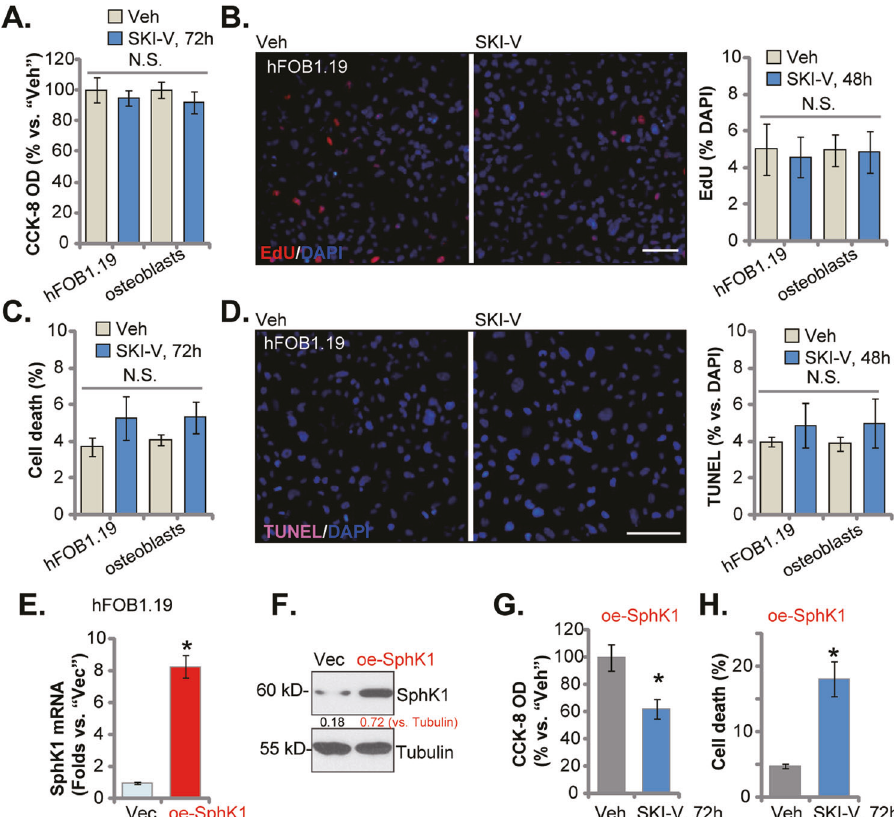
Fig. 3 The effect of SKI-V in hFOB1.19 human osteoblastic cells and primary osteoblasts. The hFOB1.19 human osteoblastic cells or the primary human osteoblasts ( “ osteoblasts ” ) were cultured and treated with SKI-V (25 μ M) for applied time periods; cell viability, proliferation, death, and apoptosis were tested by CCK-8 ( A ), nuclear EdU staining ( B ), trypan blue staining ( C ) and nuclear TUNEL staining ( D ) assays, respectively. “ Veh ” stands for the vehicle control. Data were presented as mean ± standard deviation (SD, n = 5). Expression of the SphK1 mRNA ( E ) and protein ( F ) in the stable hFOB1.19 cells with the SphK1-expressing lentiviral construct ( “ oe-SphK1 ” ) or the empty vector ( “ Vec ” ) was shown. The oe-SphK1 hFOB1.19 cells were treated with SKI-V (25 μ M) or vehicle control for 72 h; cell viability and death were tested by CCK-8 ( G ) and trypan blue staining ( H ) assays, respectively. “ N. S. ” stands for non-statistical difference ( P > 0.05). * P < 0.05 vs . “ Vec ” / “ Veh ” group. Experiments were repeated fi ve times with similar results obtained. Scale bar = 100 μ m ( B and D